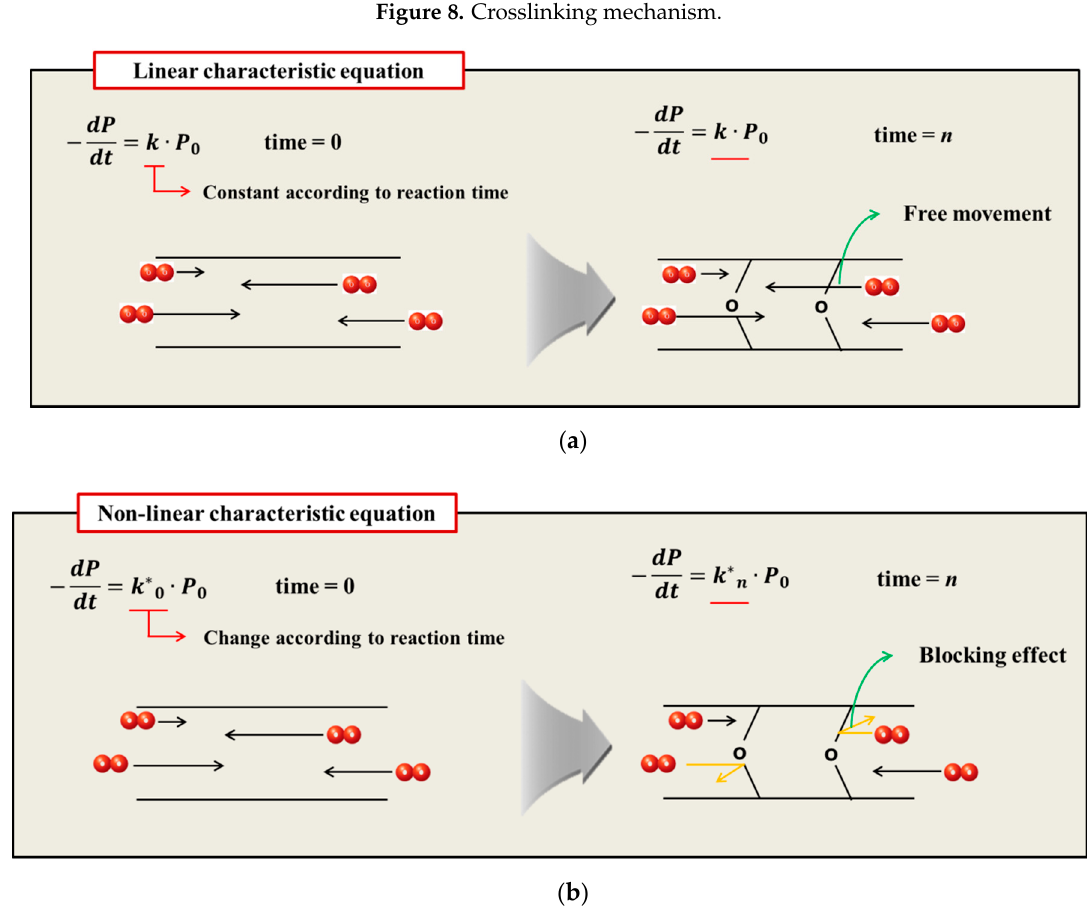
Figure 9. ( a ) General aging reaction; ( b ) Aging reaction according to the oxygen permeation block effect of crosslink structure.